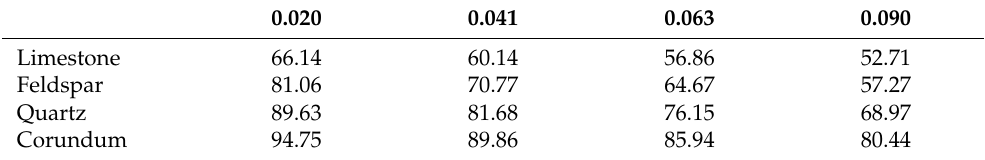
Figure 6. Laser granulometry of materials in milling mode at 250 rpm . Table 13. Laser granulometry analysis of materials after grinding, over sieve (%). Table 13. Laser granulometry analysis of materials after grinding, over sieve